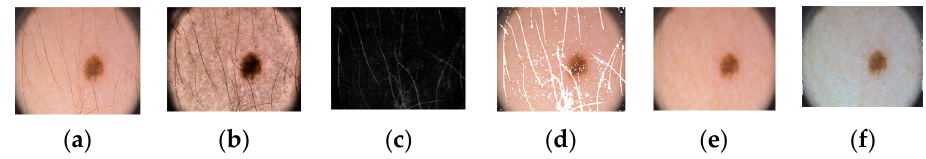
Figure 2. Preprocessing steps: ( a ) original image, ( b ) contrast-enhanced image, ( c ) hair mask, ( d ) hairless image with removed pixel information, ( e ) hairless image, and ( f ) gray-color image.